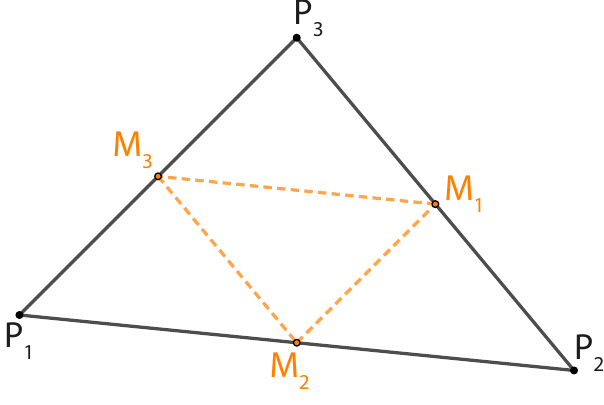
Figure 7. Refinement of the triangles by bisecting its